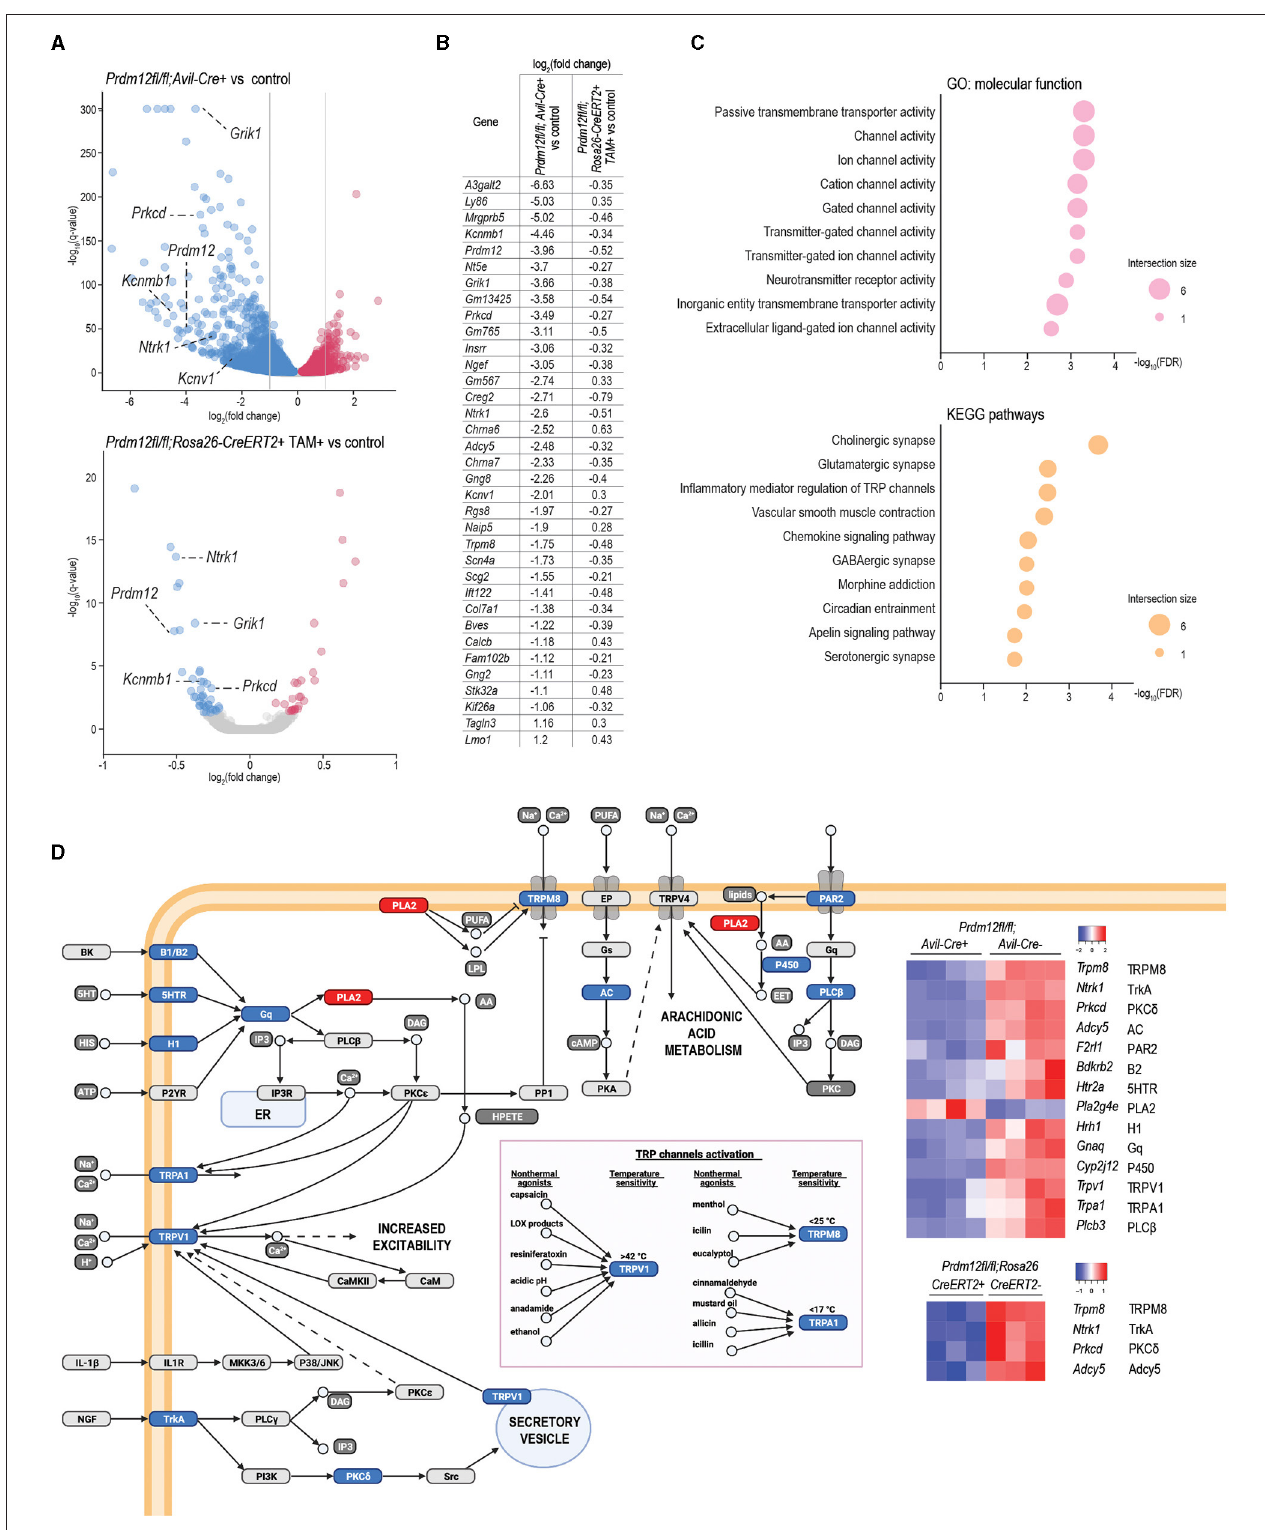
FIGURE 5 | Transcriptomics analysis of DRG of Prdm12-deficient animal models. (A) Volcano plot of differentially expressed genes (DEGs) depicts significantly upregulated and downregulated genes in pooled lumbar DRG isolated from adult Prdm12 fl / fl ; Avil-Cre + (upper panel, four biological replicates) and Prdm12 fl / fl ; Rosa26-ER T 2 + (lower panel, three biological replicates) as compared to their respective control littermates. X-axis represents log 2 fold change and the y-axis